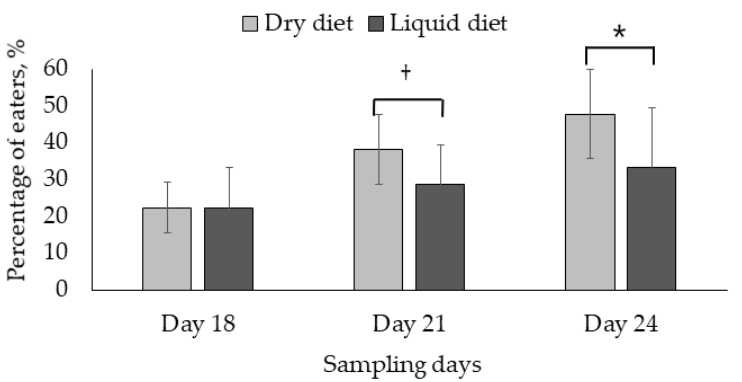
Figure 2. The percentage of piglets fed a dry- or liquid creep diet, categorized as eaters during the three different sampling days. * Statistical significance between dietary treatments ( p < 0.05) and † statistical tendency between dietary treatments ( p < 0.1).